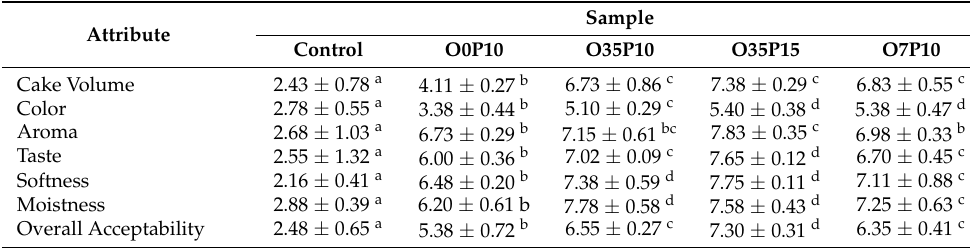
Overall Acceptability